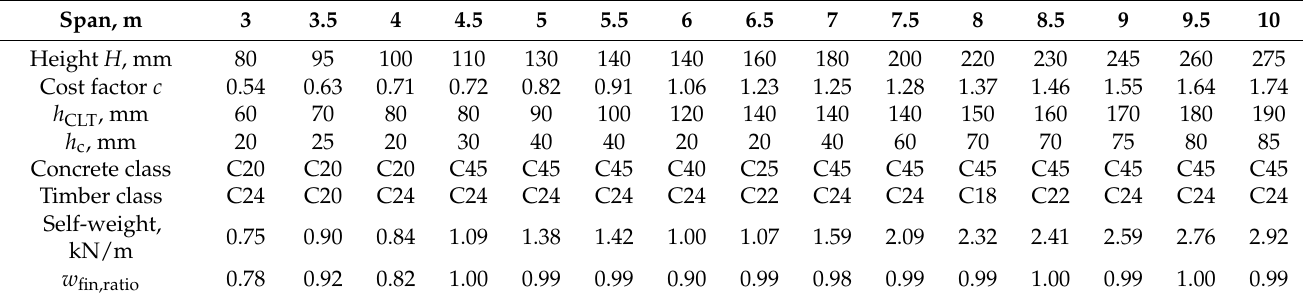
Table 5. The most rational cross-sectional parameters of the CLT–concrete composite panel for cat- egory A1.